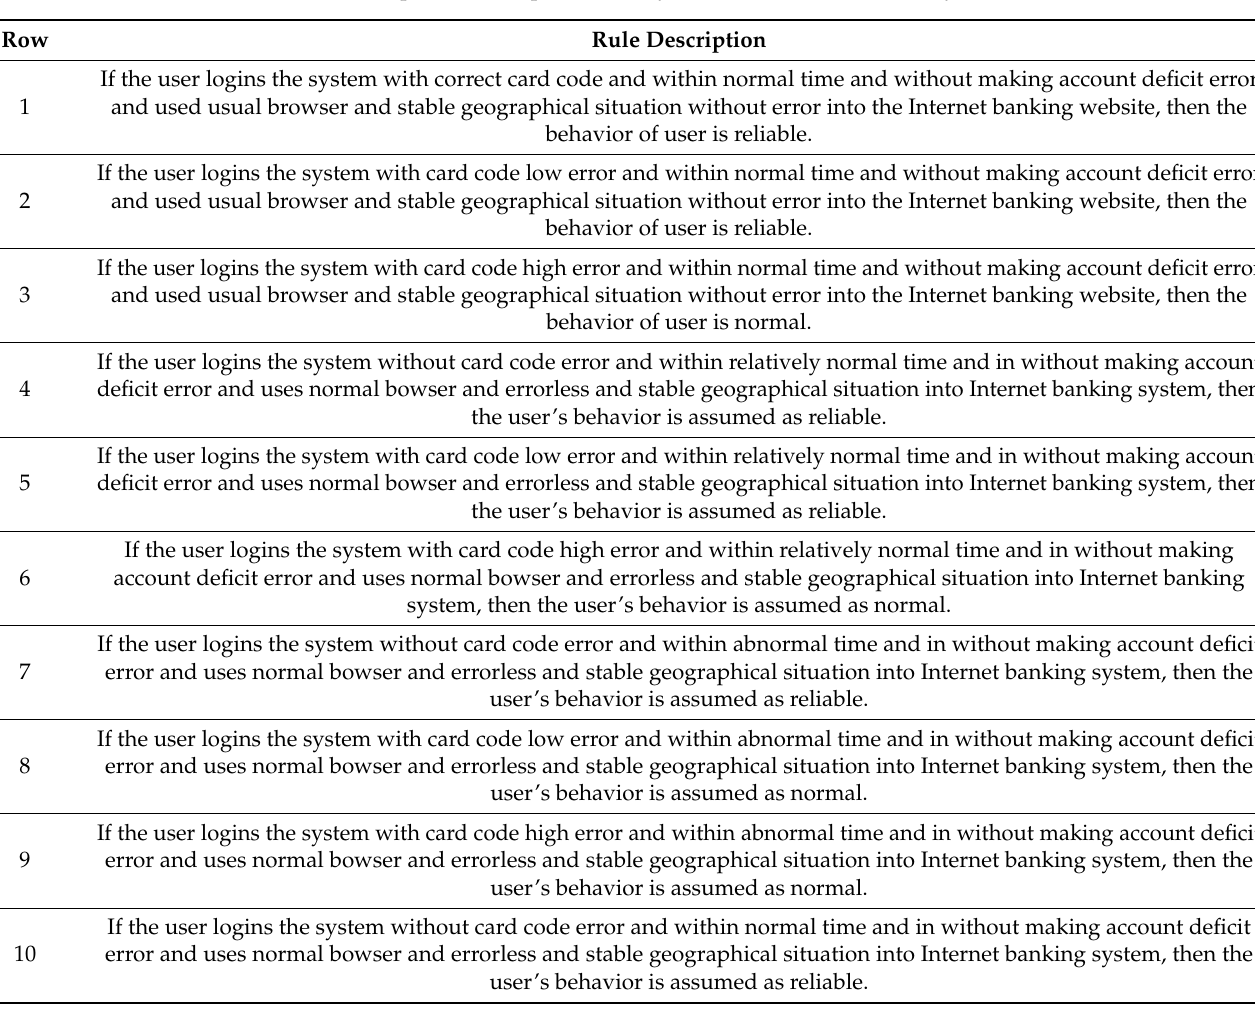
Table 11. Examples of description of fuzzy rules (source: research